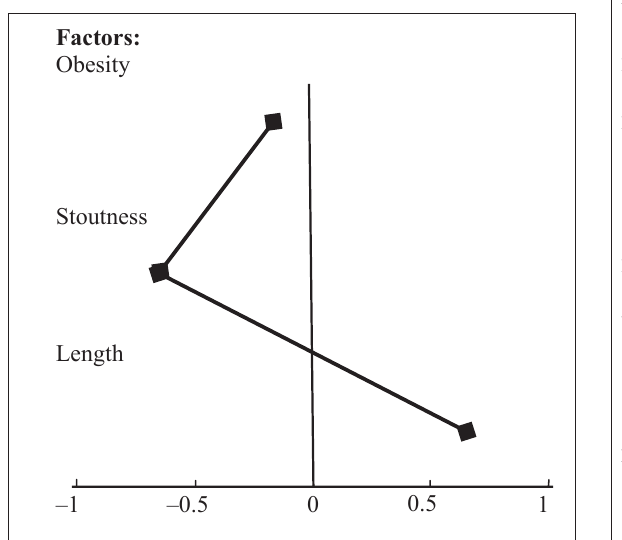
Fig. 2. Natural indices of the somatic features within the factors in the members of the female national tennis team of Poland (n =